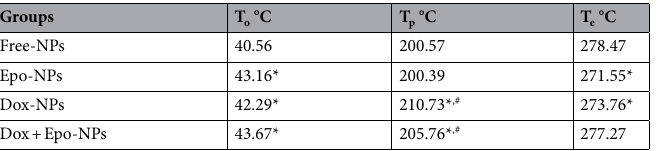
Table 3. DSC values for all nanoparticles. T o (temperature at which peak starts), T p (peak temperature) and T e (temperature at which peak ends). Mean temperature of NPs by DSC. *Values significantly different from Free-